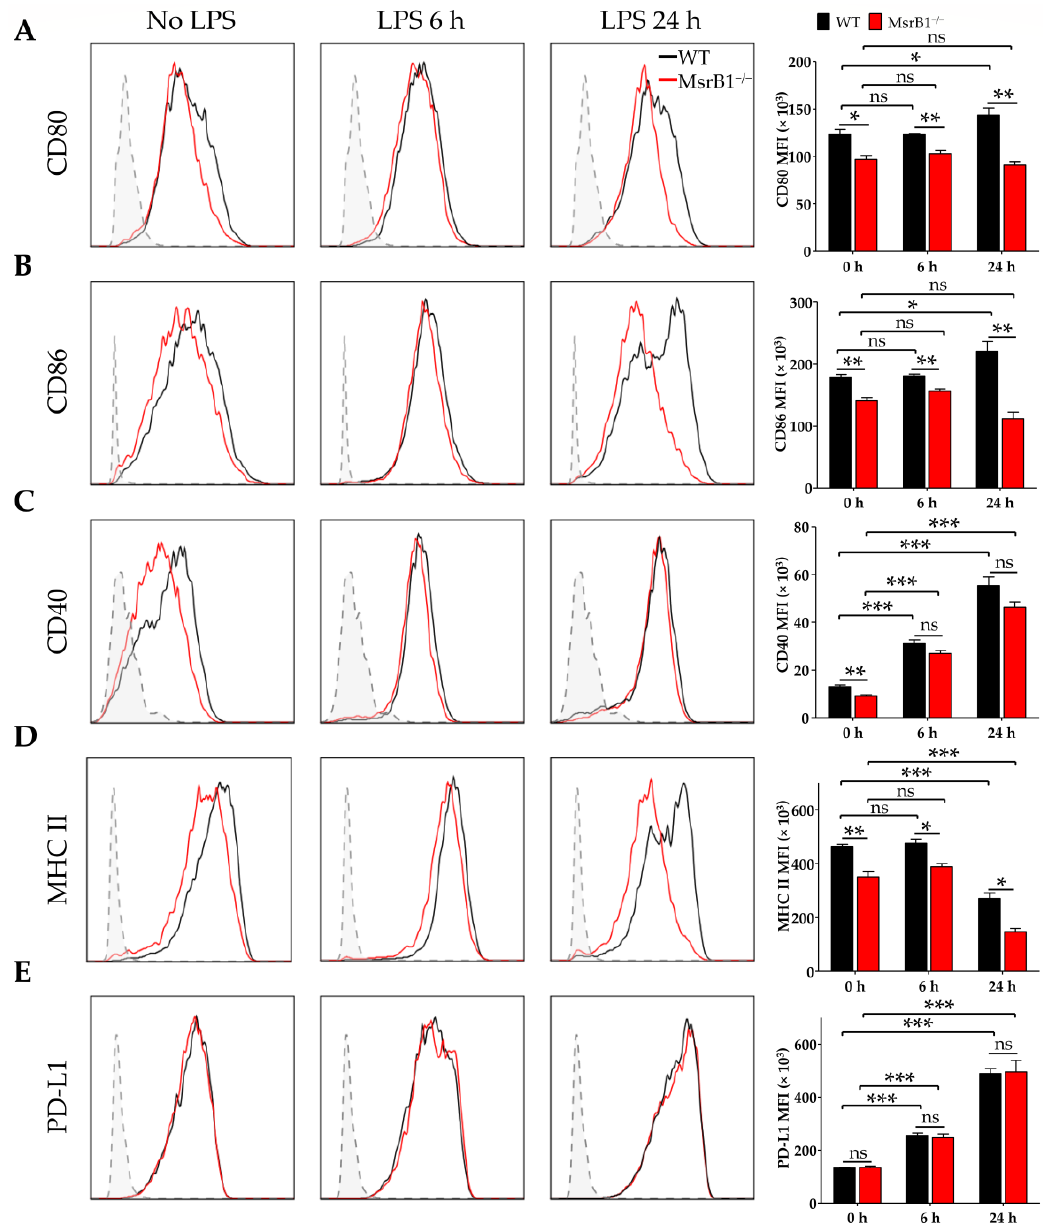
Figure 1. Methionine sulfoxide reductase (Msr)B1 is needed for normal lipopolysaccharide (LPS)-induced maturation of dendritic cells (DCs). Bone marrow-derived DCs (BMDCs) from wild-type (WT) and MsrB1 −/− mice were stimulated with LPS for the indicated durations ( n = 3 per group) and their expression of CD80 ( A ), CD86 ( B ), CD40 ( C ), major histocompatibility complex (MHC) II ( D ), and PD-L1 ( E ) were analyzed by flow cytometry with gating on the CD11c + CD11b + BMDCs in the live cells. In all figures, MFI stands for mean fluorescence intensity. Fluorescence minus one (FMO) controls (gray) are shown in each histogram. Mean ± SEM are shown. * p < 0.05, ** p < 0.01, *** p < 0.001; ns, not significant, as determined by unpaired t- test. The data shown are from one of four independent experiments, all of which had similar results.